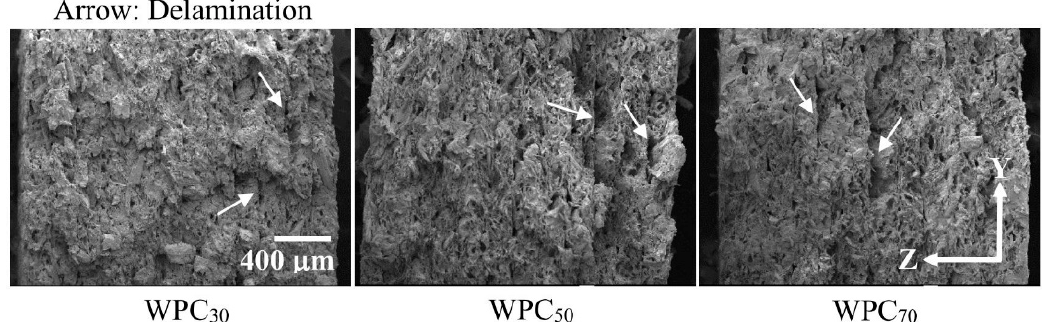
Figure 9. SEM micrographs of the fracture cross-sectional surfaces of WPC parts printed at various printing speeds.